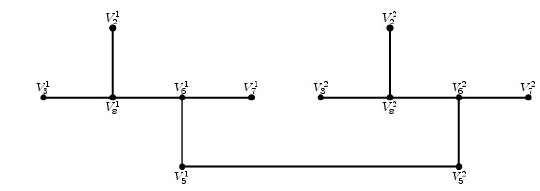
2 Acyclic Vertex Set of G